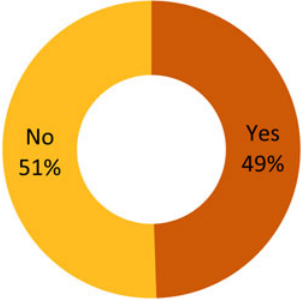
Fig. 8. Percentage of students who report accessing the tutoring services.